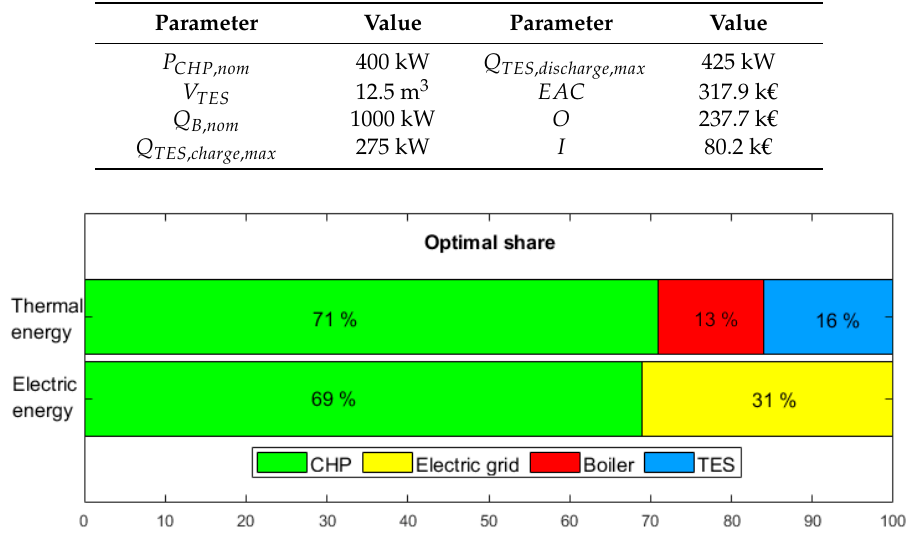
Table 6. Results from case-study optimization.